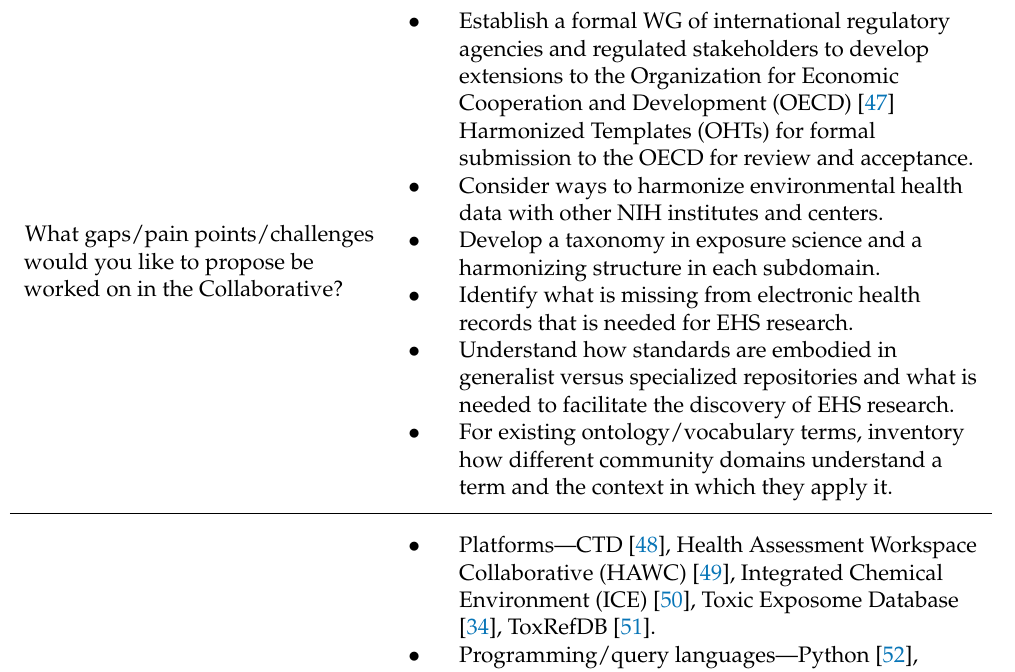
Table 3. Attendee feedback on three questions about semantic needs, gaps, and strategies for future research